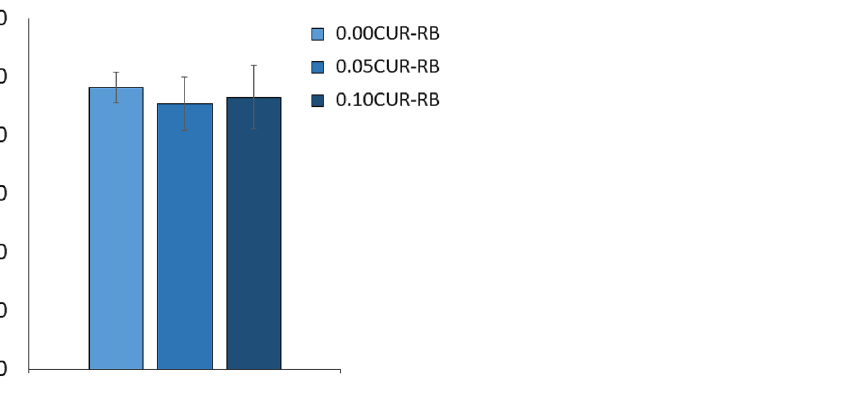
Figure 4. Flexural strength as a function of curcumin concentration. Data reported as average (MPa) ± one standard deviation (n = 13). No statistically significant differences were detected.